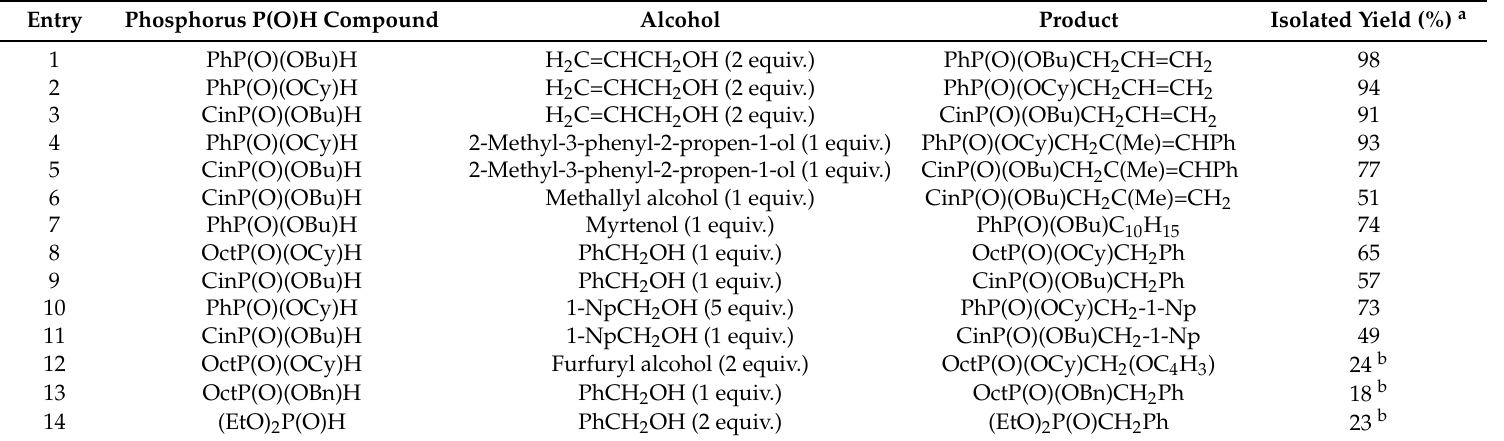
Table 3. Allylation and benzylation of various phosphinylidene